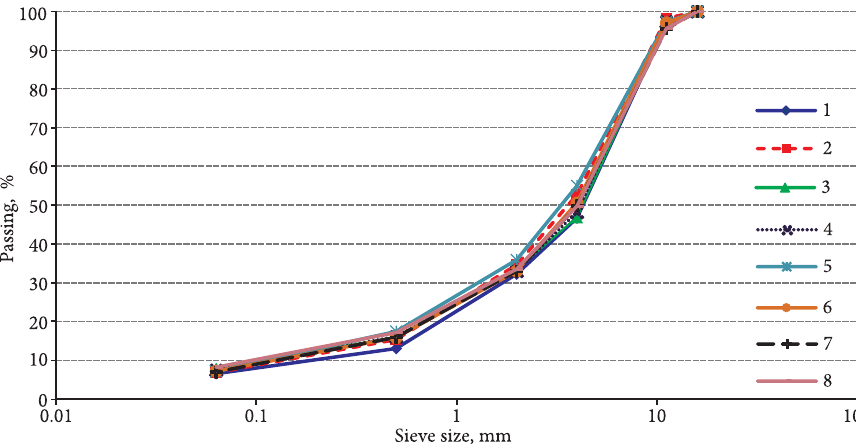
Fig. 7. Aggregate gradation of tested mixtures AC